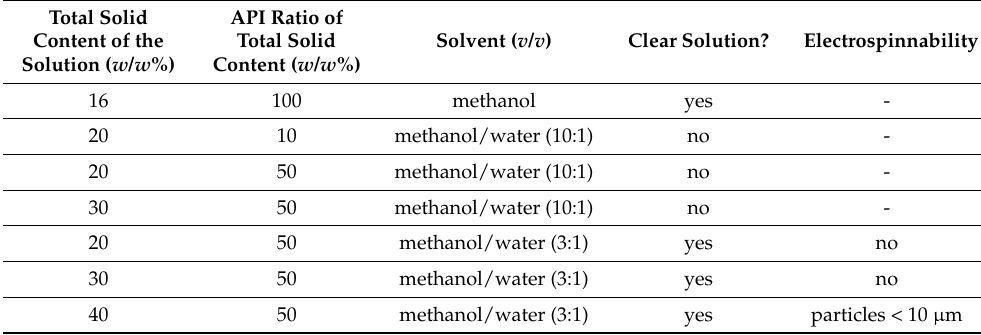
Table A2. Solution preparation of ASO2 and HP β CD in methanol–water. The electrospinnability of the so-lutions was tested using laboratory-scale HSES